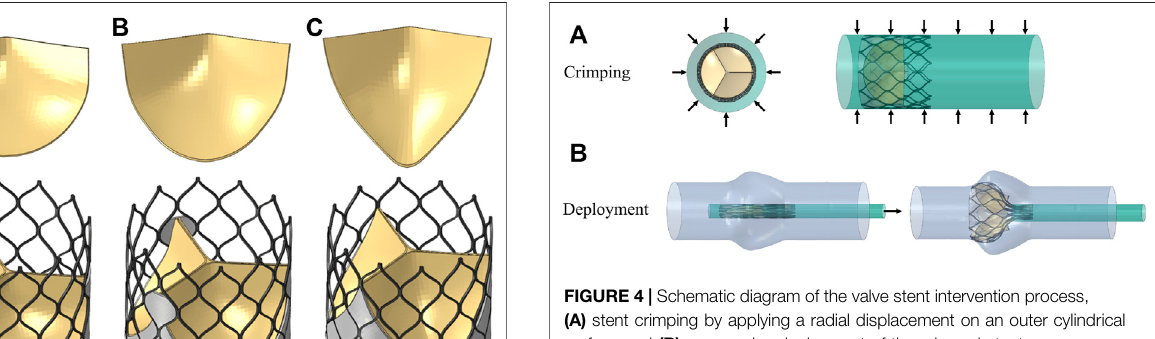
stretched to a strain of about 13.5%, and all the test data were recorded. The experimental data were fi tted to a stress-strain curve, and the curve was used for simulation analysis as shown in Figure 5 . The material property parameters were: E 59,000 MPa, martensitic elastic modulus E M = 26,100 MPa, Poisson ’ s ratio = 0.33, and the tensile limit of the material = 13.5%.